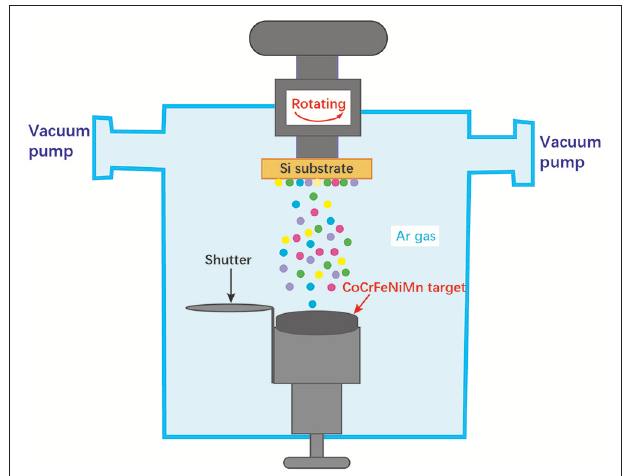
FIGURE 1 | Schematic illustration of the CoCrFeNiMn high-entropy thin film fabrication method.